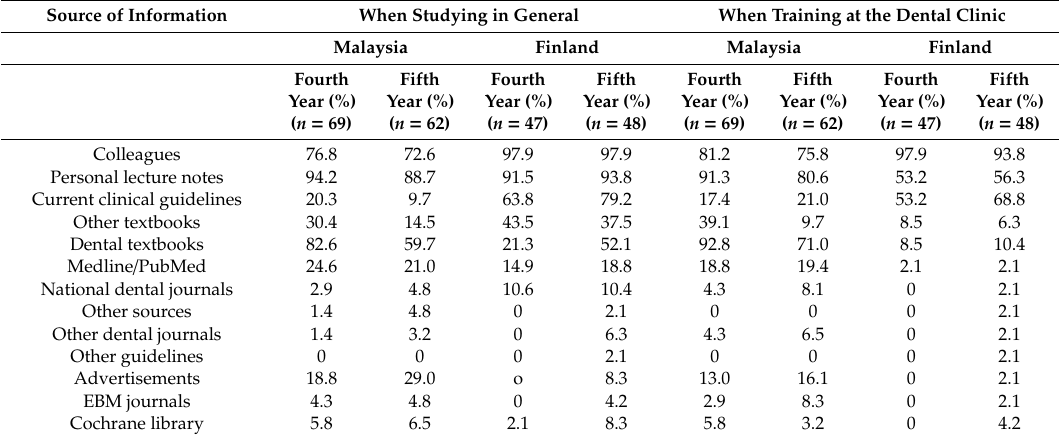
Table 3. Daily or weekly use of information sources as an undergraduate student and when training at the dental clinic among fourth and fifth-year students from Malaysia ( n = 131) and Finland ( n = 95). Source of